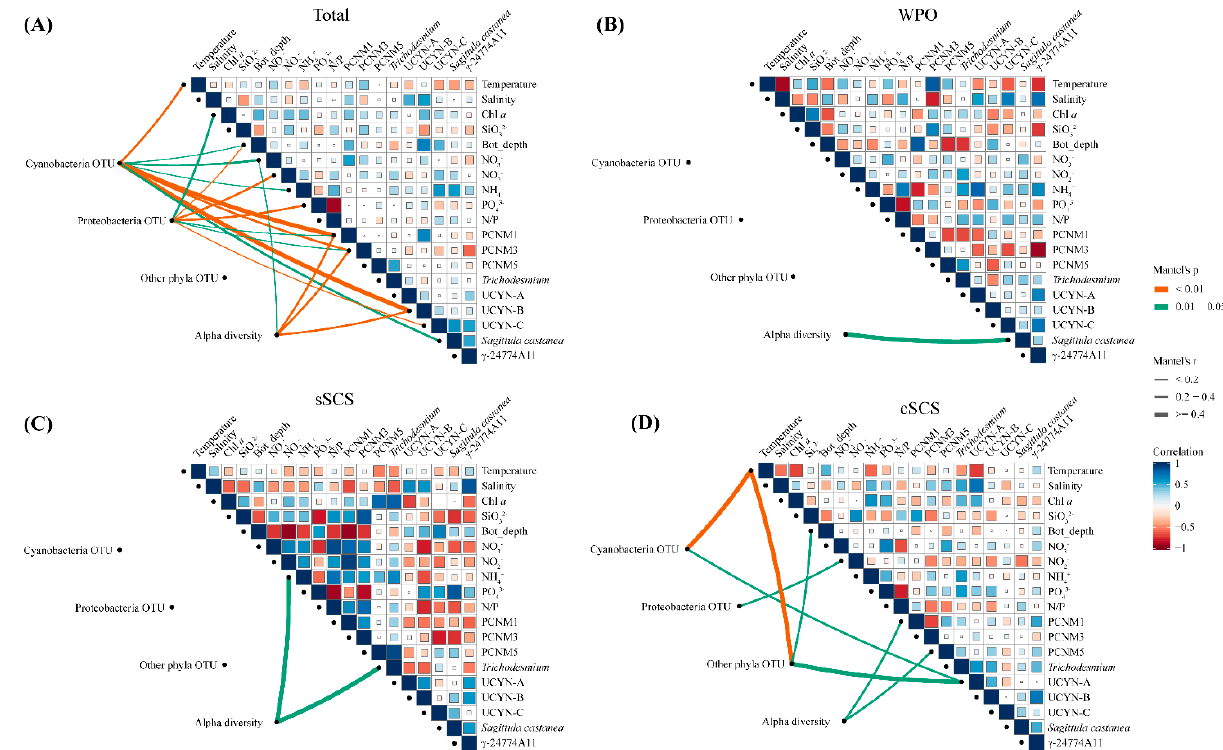
Figure 6. Mantel tests and Spearman’s correlation matrix among diazotrophic communities and environmental parameters in the total survey area ( A ), the WPO ( B ), the sSCS ( C ), the cSCS ( D ). Pairwise comparisons between environmental factors and gene copies of representative genera phylotypes (qPCR) are shown with a color gradient denoting Spearman’s correlation coefficient. The composition of diazotrophic communities (OTUs) was related to environmental parameters using Mantel tests to determine the Distribution of diazotrophs. Edge width corresponds to the Mantel’s r statistic for the corresponding correlations, and edge color denotes the statistical significance of Mantel’s p. The insignificant correlations were not be displayed.